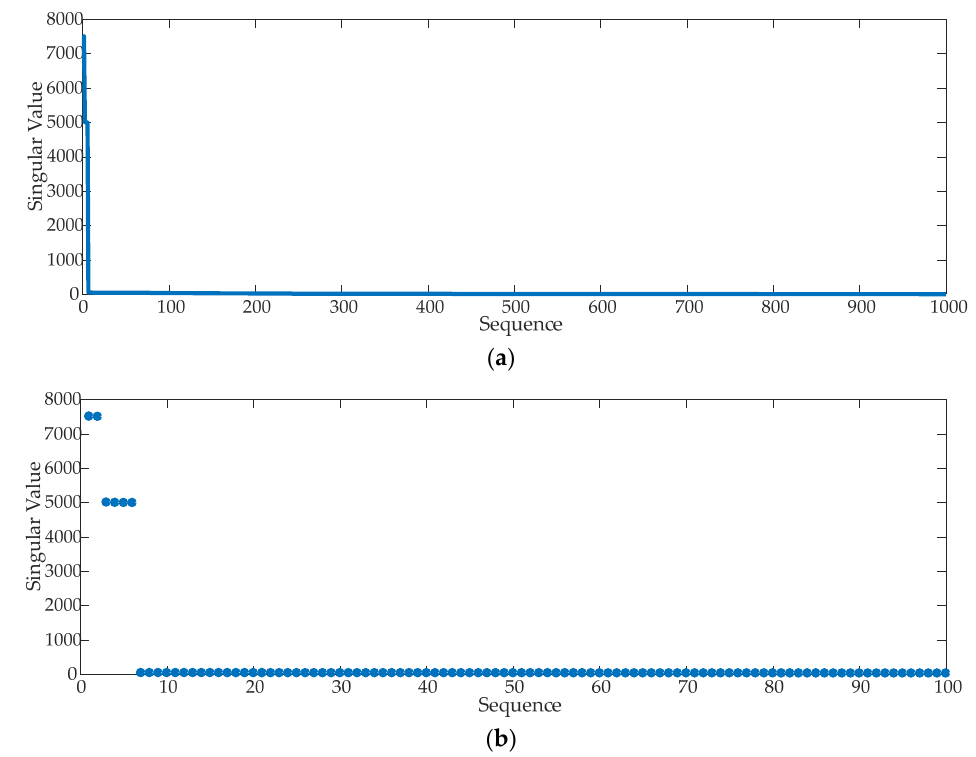
Figure 3. Singular value distribution of PD signal superimposed with the periodic narrowband interference signals. ( a ) Singular value distribution. ( b ) First 100 singular value distributions.